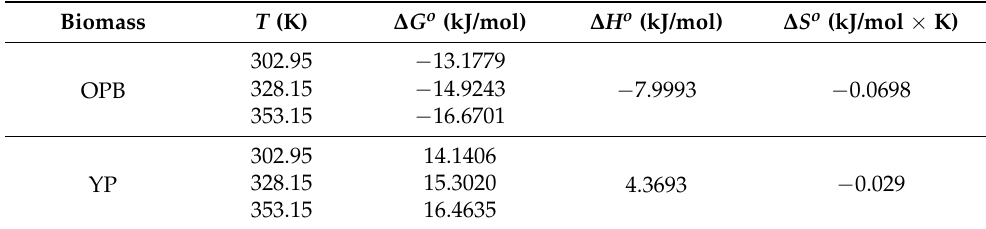
Table 9. Thermodynamic parameters for the adsorption of hexavalent chromium at pH 2, 200 rpm,